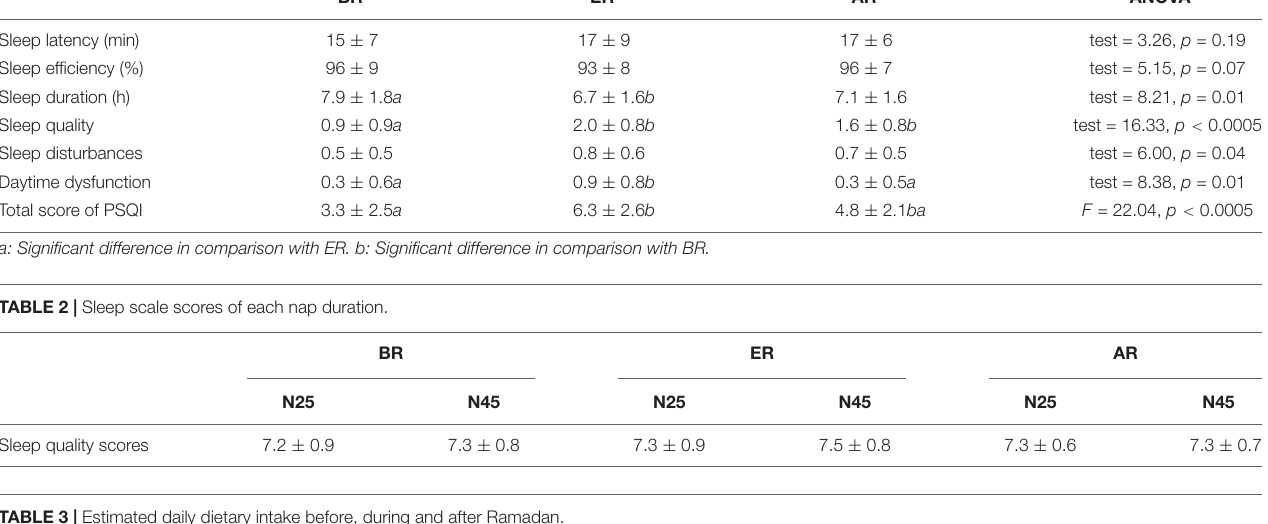
TABLE 3 | Estimated daily dietary intake before, during and after